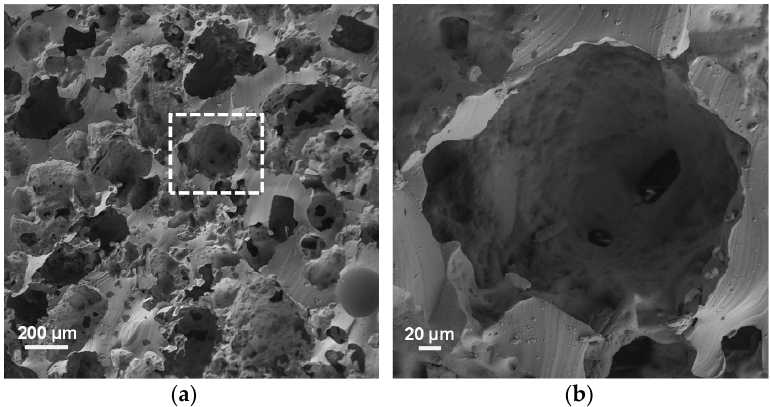
Figure 5. ( a ) SEM image of the cross-section of a PDMS foam after leaching of a preformed sugar based template; ( b ) Higher magnification view of the pore marked in ( a ).